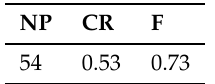
Table 4. Parameter settings of DE.